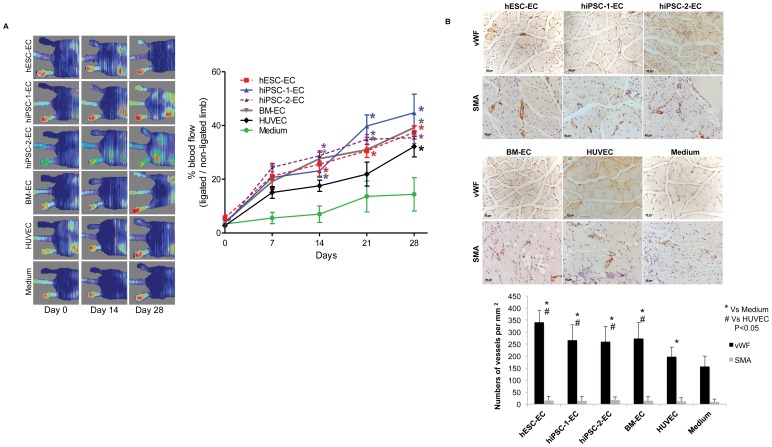
Improvement of blood perfusion in ischemic hind-limbs after transplantation of derived endothelial-like cells.(A) Laser Doppler scanning was preformed immediately after ligation of femoral artery to confirm the induction of hind-limb ischemia. Then repeated Doppler scanning was performed at Day 7, 14, 21 and 28 after transplantation of 3 million hESC-EC, two different hiPSC-ECs, BM-EC, HUVEC or medium alone into the ischemic muscle. Representative photos from the laser Doppler scanning at Day 0, Day 14 and Day 28 were shown. Blue color represents lower perfusion and red color represents higher perfusion (upper panel). In each animal, limb perfusion was quantified and the average of the perfusion ratio against the control limb was calculated in different time point (lower panel). As compared with medium injection, there was progressive and significant improvement of blood flow over the ischemic limbs after hESC-EC, hiPSC-ECs, BM-EC and HUVEC transplantation (n = 6 in each group, *p<0.05 vs. medium control at different time points). However, there were no significant differences in the blood flow over the ischemic limbs among those mice after hESC-EC, hiPSC-EC and BM-EC transplantation (p>0.05 at different time points). (B) Representative photos show the immunohistochemical staining for von Willebrand factor (vWF) and smooth muscle actin (SMA) of histological sections over the ischemic limbs at Day 28 after hESC-EC, hiPSC-EC, BM-EC or medium injection (upper panel). The number of vessels with positive staining (brown color) for vWF and SMA were determined under a light microscope with ×400 magnification with 20 random fields. As compared with medium injection, there were significant higher number of vessels with vWF positive but not SMA over the ischemic limbs after hESC-EC, hiPSC-ECs and BM-EC transplantation (*p vs. medium control and * vs HUVEC, p<0.05). However, there were no significant differences in the number of vessels with vWF and SMA positive over the ischemic limbs among those mice after hESC-EC, hiPSC-EC and BM-EC transplantation (p>0.05).